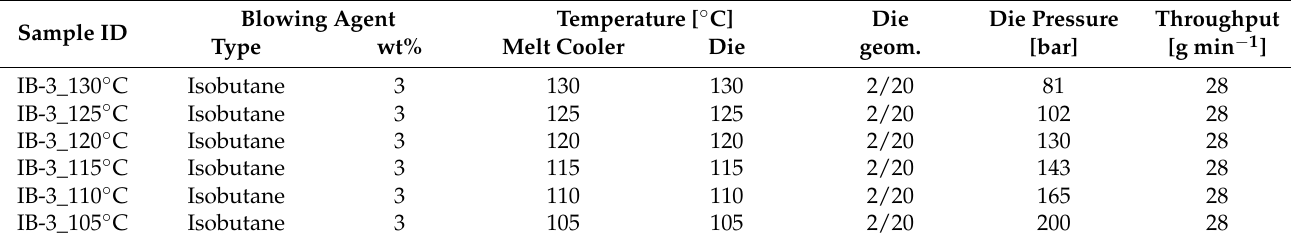
Table 3. Processing parameters used during production of temperature survey